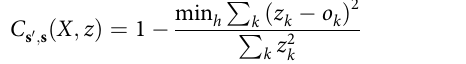
i , the results show that increasing the polynomial in h x R k for higher delays τ . In particular, we fi nd that the reservoir can solve the well-known XOR problem for nonlinearity degrees d ≥ 2, which coincides with the parity check at τ = 1. The parity check at τ = 3 works, in turn, for d ≥ 4.